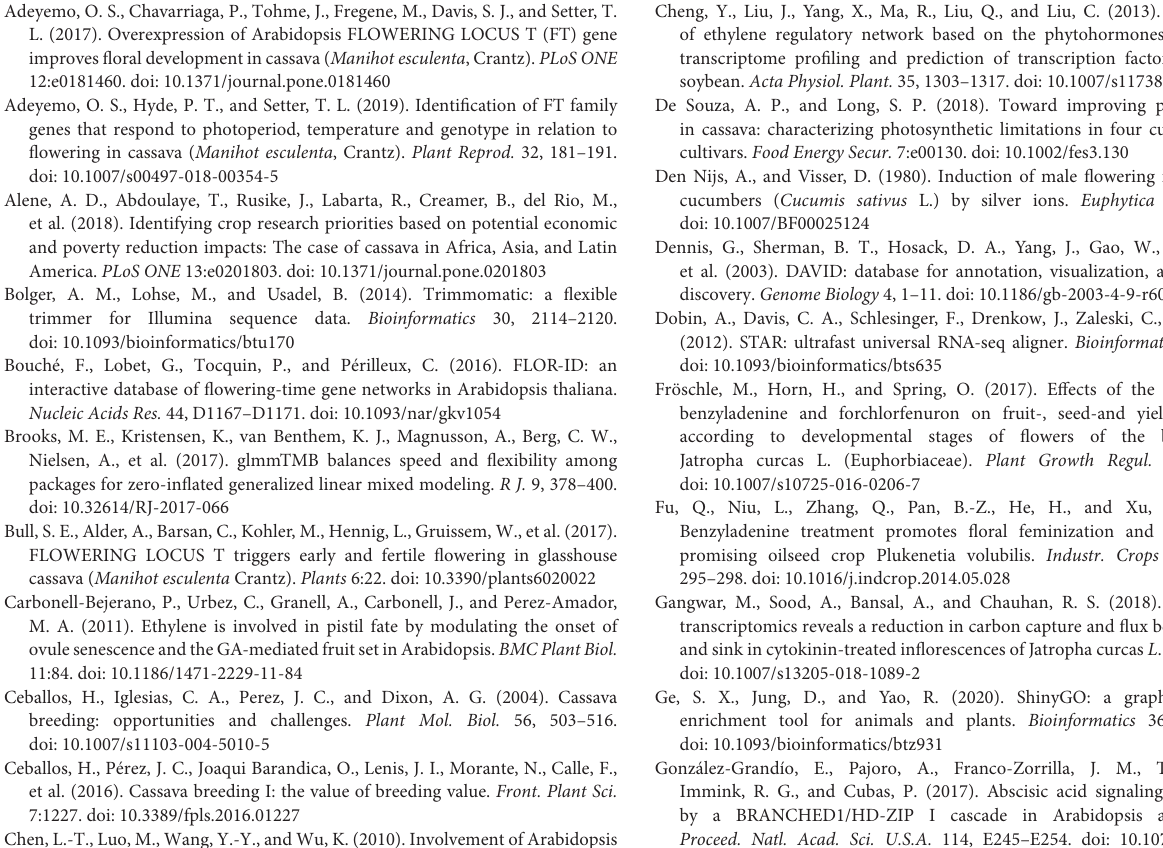
(2018–2019). Shown are the effects of PGRs and pruning on: total flower numbers, female flower numbers, fruit numbers, and proportion of female flowers (reflecting only plants with at least one flower).